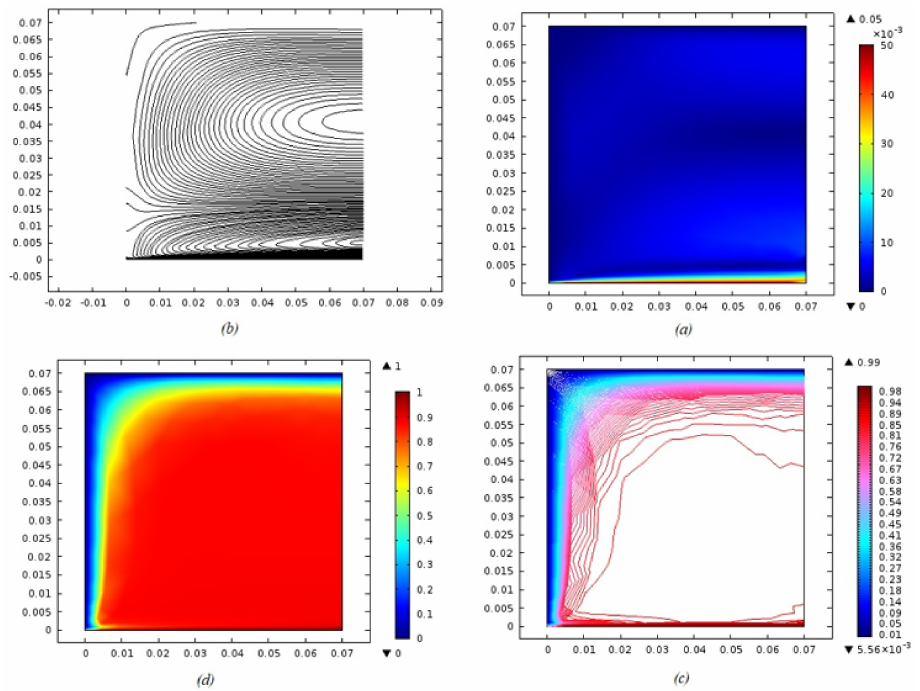
Figure 15. ( a ) Surface plot for velocity; ( b ) streamlines; ( c ) surface plot for temperature; ( d ) isothermal contours using M = 0.5, k p = 1, U w = 0.05.